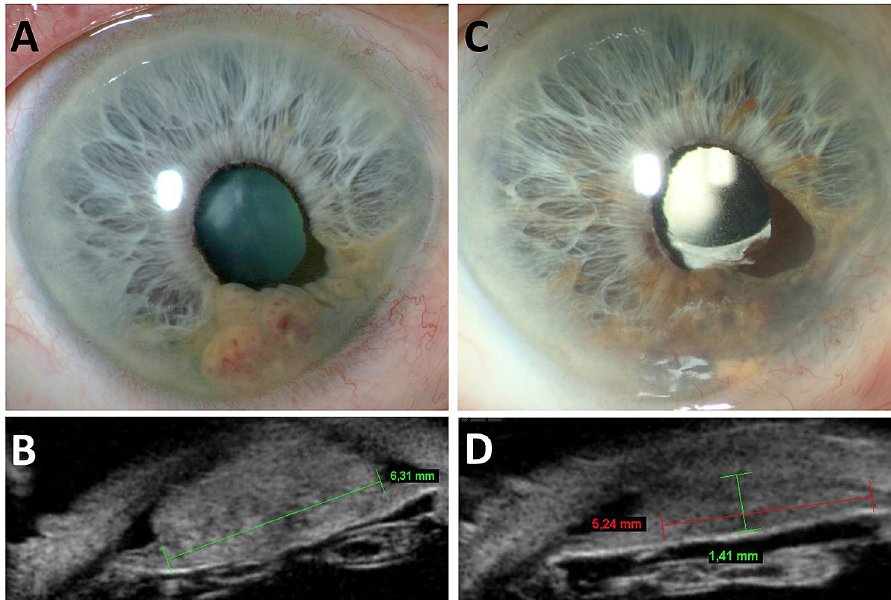
Figure 1. An 85 year old male patient with suspect iris lesion was observed over seven years. When enlargement of the lesion was suspected, a biopsy was performed, which eventually confirmed the diagnosis of iris melanoma. ( A , B ) The patient was subsequently treated with CyberKnife and responded with regression of tumor at last follow-up two years later ( C , D ).